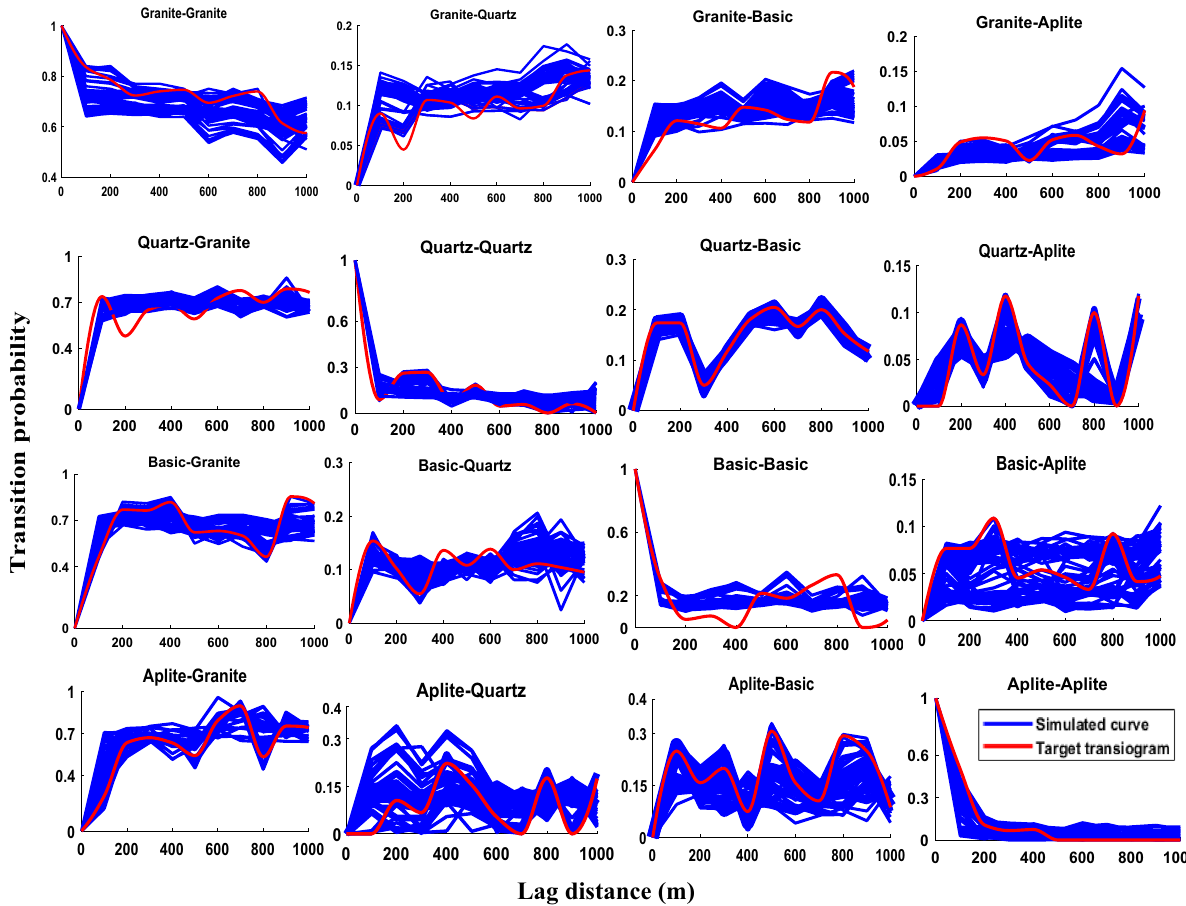
Figure 10. Transiograms of 50 simulated realizations and target transiogram of four